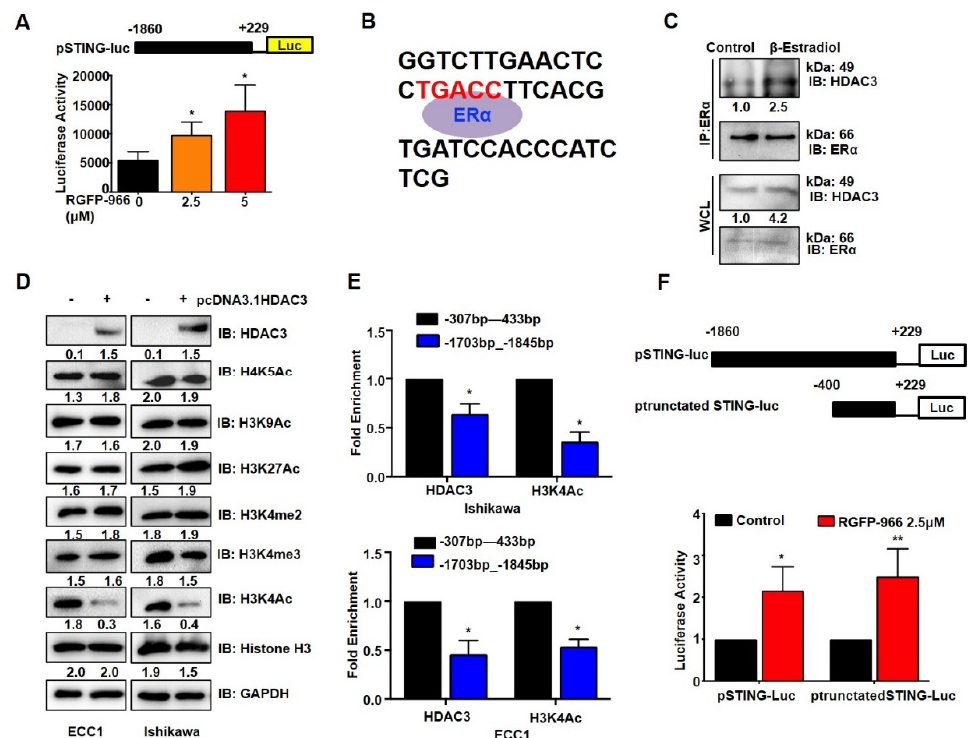
Figure 5. β -estradiol-ER α recruits HDAC3 to STING promoter and deacetylates H3K4. ( A ) HEK 293T cells were transfected with STING promoter–reporter plasmid for 24 h, the Renilla plasmid as control; cells were treated with an increasing dose of RGFP-966 for another 24 h, and luciferase activities were measured. ( B ) The DNA sequence of the STING promoter was analyzed using promo. ( C ) IB analysis of WCL and IP derived from Ishikawa cells treated with 10 nM β -estradiol for 24 h. ( D ) IB analysis of WCL derived from Ishikawa and ECC1 cells transfected with pcDNA3.1- HDAC3 for 24 h. ( E ) Ishikawa (up) and ECC1 (down) cells were subjected to ChIP assay using HDAC3 or H3K4Ac antibodies. Immunoprecipitated DNA was measured by qPCR using primer for human STING promoter ( − 307_ − 433, − 1703_ − 1845). ( F ) HEK 293T cells were transfected with control STING promoter–reporter and truncated STING promoter–reporter plasmid, respectively, plus a Renilla plasmid as an internal reference for 24 h, then treated with 2.5 μ M of RGFP-966 for 24 h, and then subjected to luciferase activity assay. Original image of Western blot can be found in File S1.